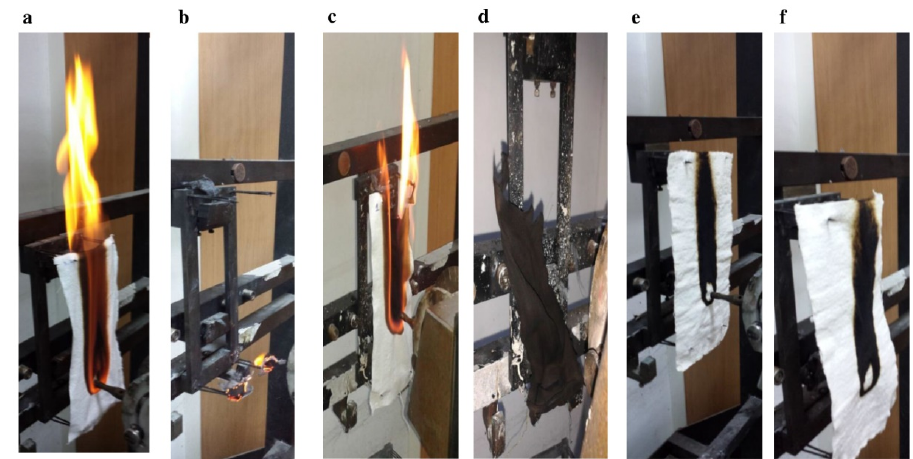
Figure 19. ( a ) Flammability test of untreated cotton fabric after 20 s; ( b ) after 45 s; ( c ) CPTS treated cotton after 20 s; ( d ) after 67 s; ( e ) MCPTS treated cotton after 20 s and ( f ) PCPTS treated cotton after 20 s (Reproduced from [147], with kind permission of Springer).